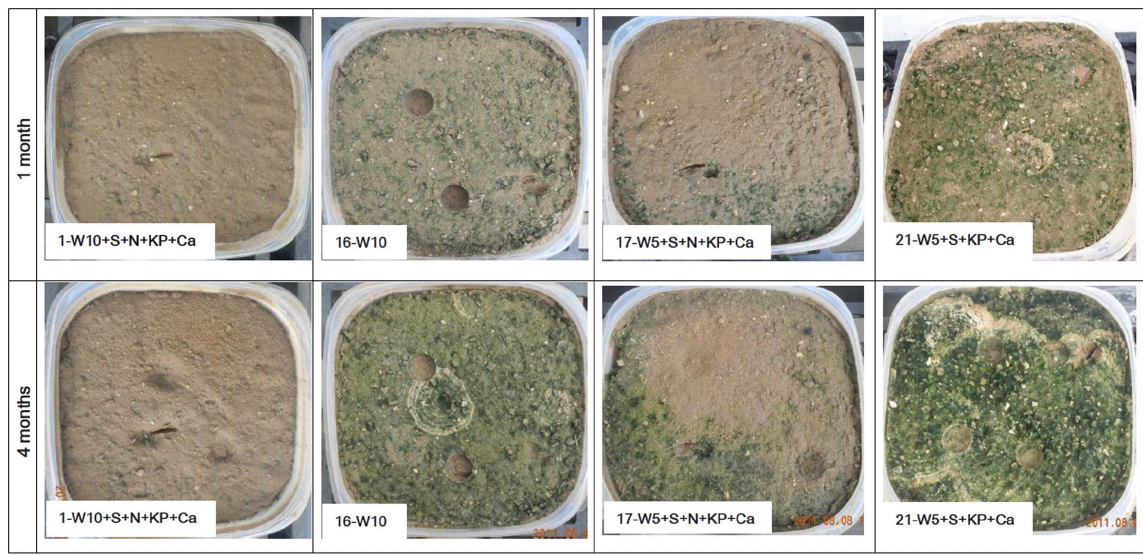
Figure 1. Visible changes in the soil surfaces after 1 and 4 months of cultivation in selected treatments.